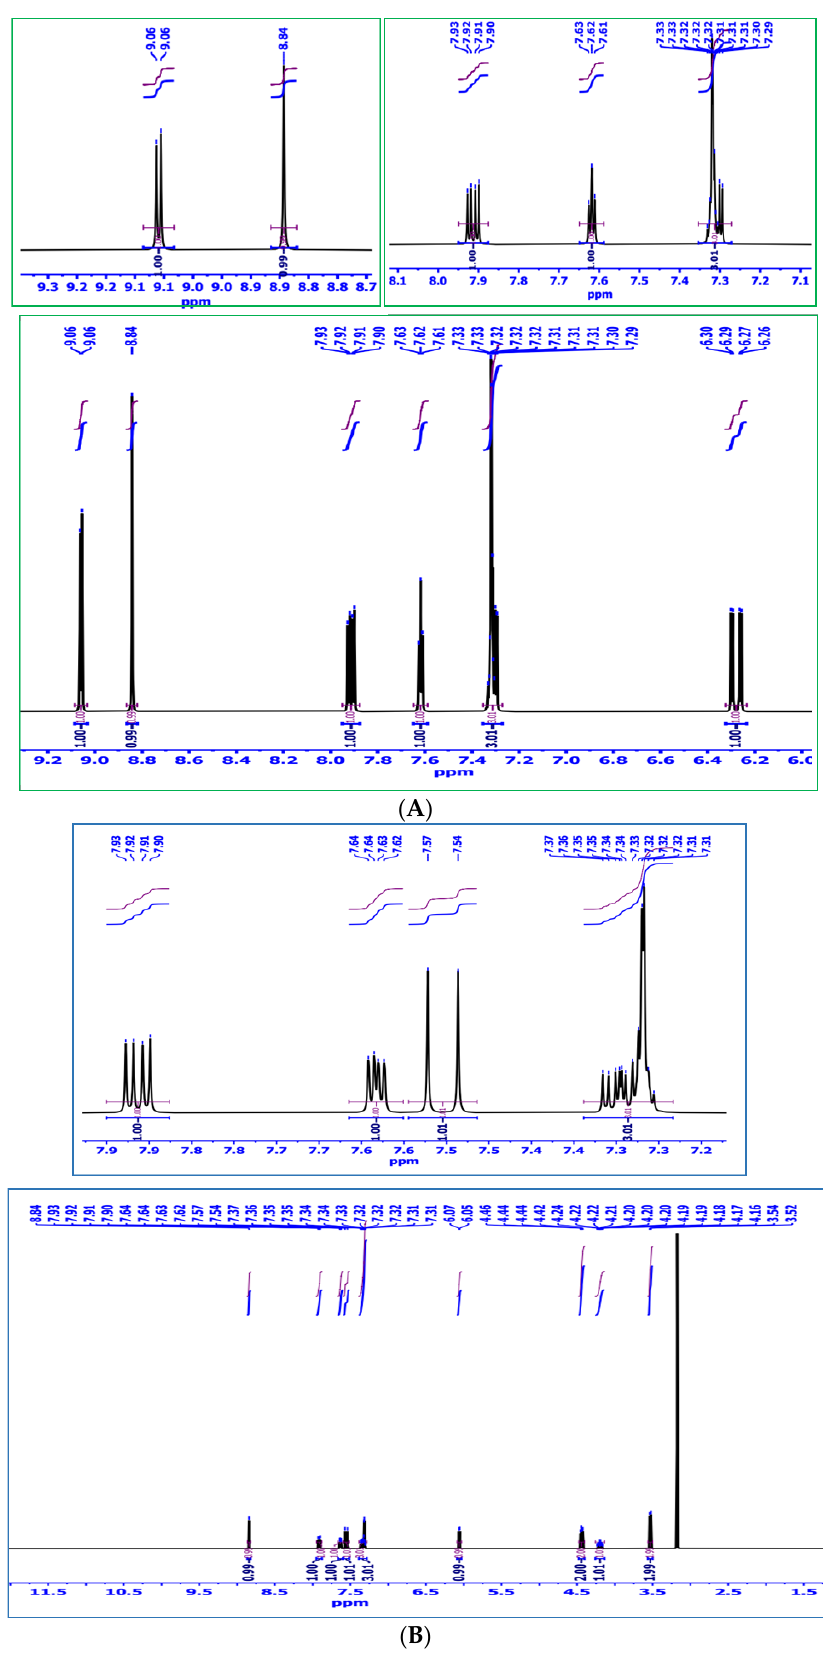
Figure 3. 1 H-NMR spectra of ( A ) HNAP and ( B ) HNAP/QA.